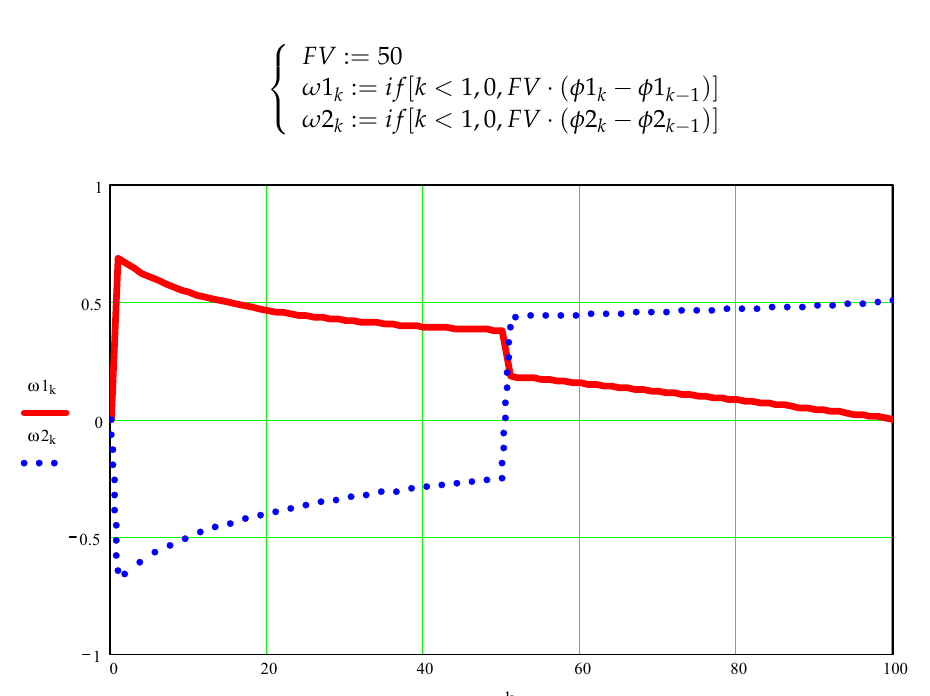
Figure A4. Values of angular velocities ω 1 and ω 2 (in hertz) as a function of the independent variable k.